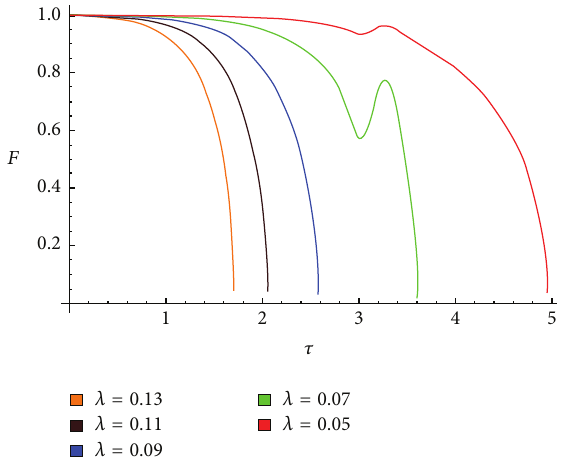
Figure 4: Plot of 𝐹 = Tr (𝜌 1 𝜌 2 ) + (1/2)(2 − Tr 𝜌 2 1 − Tr 𝜌 2 2 ) versus 𝜏 for different values of 𝜆